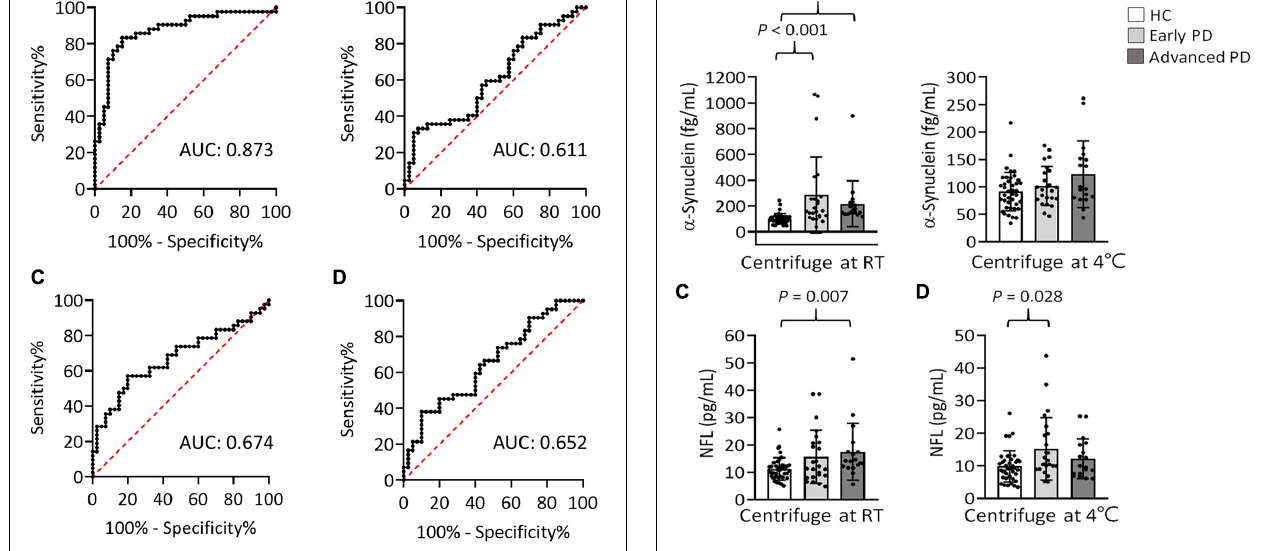
FIGURE 5 | The potentials to discriminate PD and HCs. (A,B) Receiver operating characteristic (ROC) curves for plasma levels of α -synuclein in K 2 -EDTA tubes centrifuged at (A) RT or (B) 4 ◦ C to discriminate patients with PD from HCs. (C,D) ROC curves for plasma levels of NFL in K 2 -EDTA tubes centrifuged at (C) RT or (D) 4 ◦ C to discriminate patients with PD from HCs. AUC, area under the ROC curve.